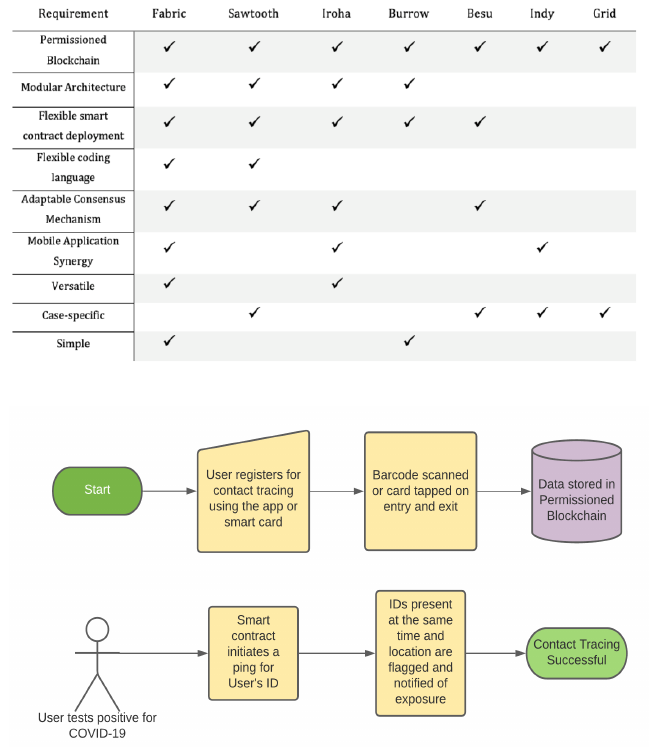
Figure 3: Workflow of proposed blockchain-based contact tracing.